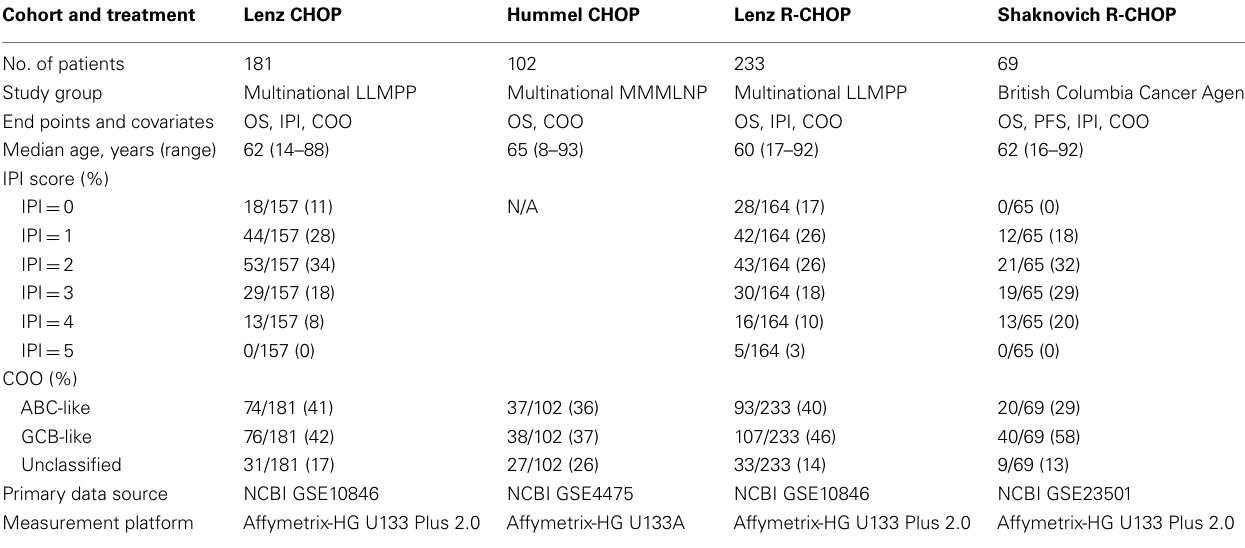
Table 1 | Summary of DLBCL GEP cohorts